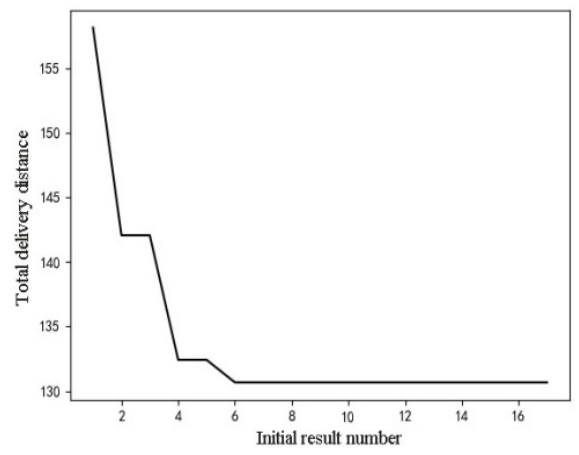
Figure 10. Iteration curve of depot B. Figure 10. iteration curve of depot B.